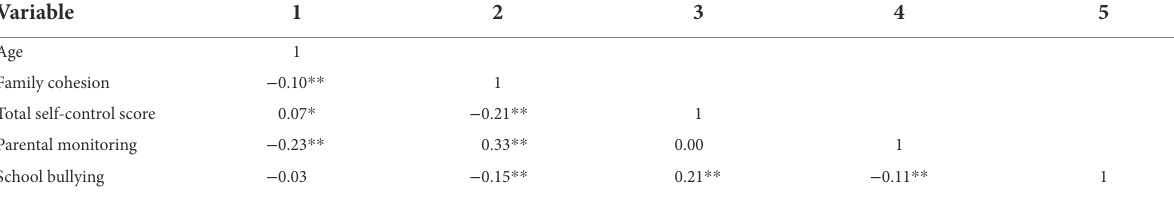
TABLE 2 Correlation coefficients for each variable ( N = 1,026).